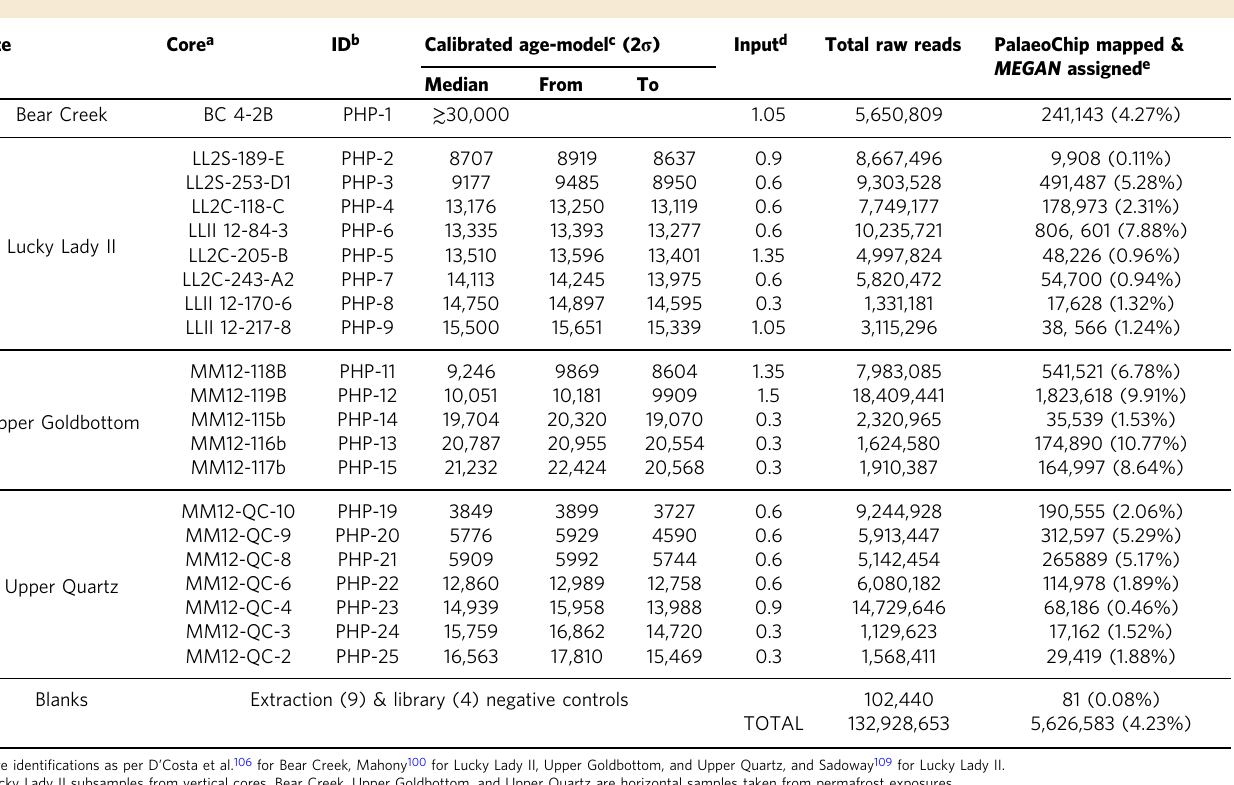
Table 1 SedaDNA permafrost